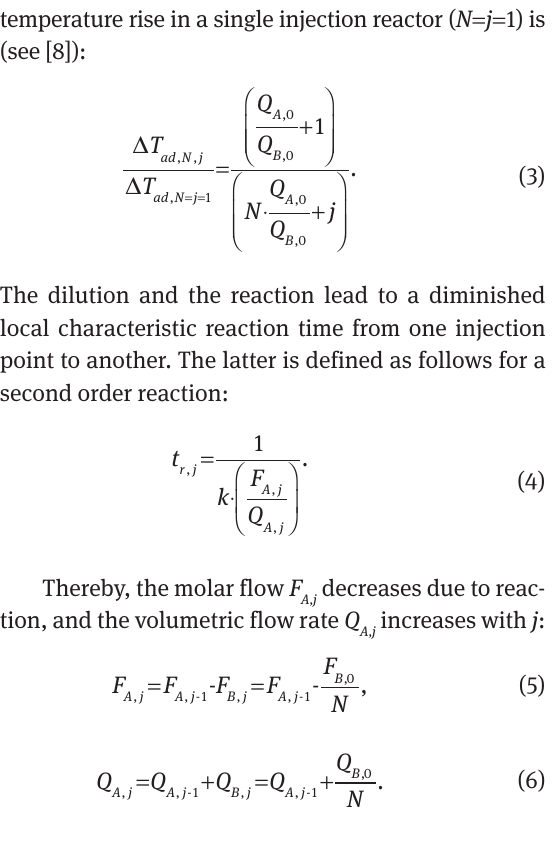
In the present example with three injection points the characteristic reaction time approximately doubles after each